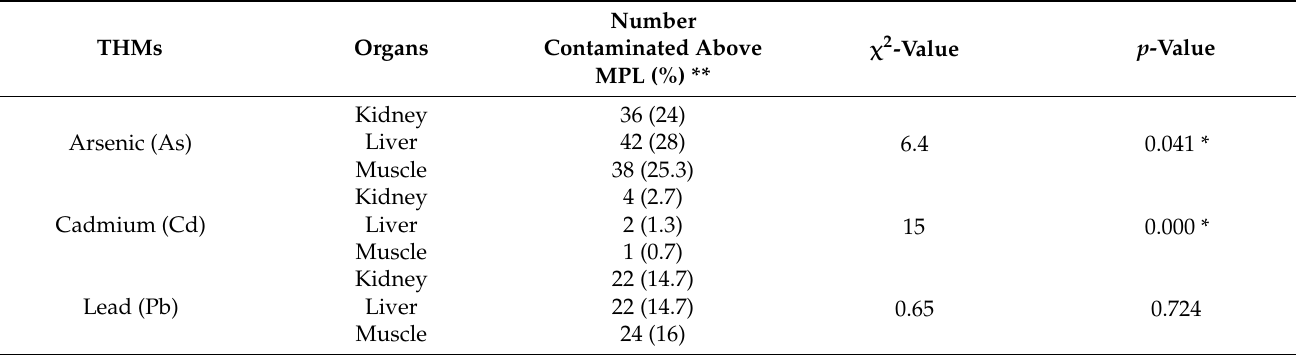
Table 4. Organs ( n = 150) distributions of toxic heavy metals (THMs) above the maximum permissible limits (MPL) in goats carcasses processed for human consumption in Enugu State, Nigeria.